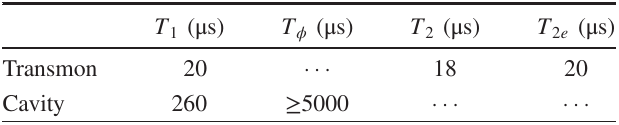
TABLE II. Coherence parameters. Summary of the coherence timescale of our system ’ s ancillary transmon and storage cavity. State-of-the-art high- Q cavities can commonly achieve T c 1 and T c 2 values of a few ms [76 –